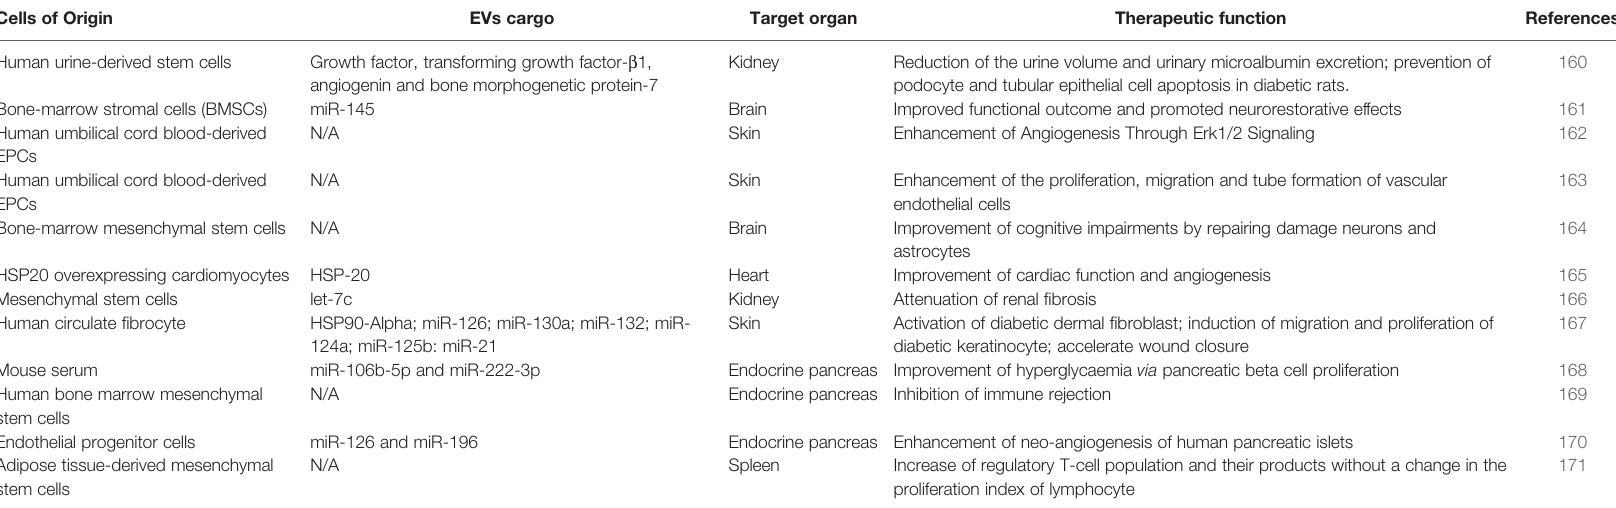
TablereportingthepotentialtherapeuticapplicationsofEVs.Inparticular,weincluded:(i)Origincellsorbio fl uidfromwhichvesiclesareisolated;(ii)themaincargoofthesevesicles;(iii)organtargetedbythespeci fi cEVspopulation;(iv)potential therapeutic function and/or mechanisms acted by released